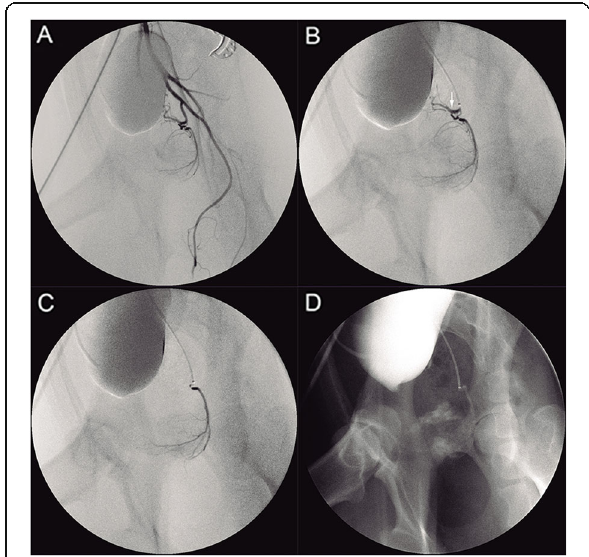
Fig. 1 PAE procedure in a dog with spontaneous BPH. Left internal iliac arteriogram ( a ) shows the prostatic artery arises from the anterior division of the internal iliac artery. b Shows the microcatheter in the left prostatic artery. The white arrow indicates the cranial branch (caudal vesical artery) of the prostatic artery. c Shows the tip of microcatheter in the prostatic branch, where microspheres are injected. d Shows radiogram immediated after PAE on the left side, indicating the mixture of microspheres with contrast medium injected into part of the left